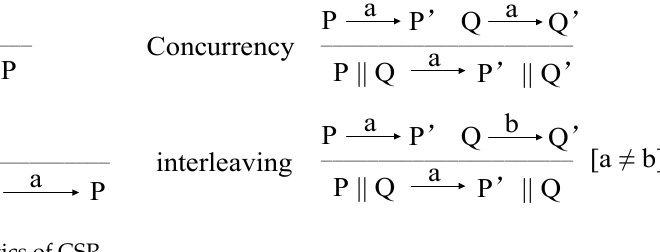
Figure 1. Operational semantics of CSP.